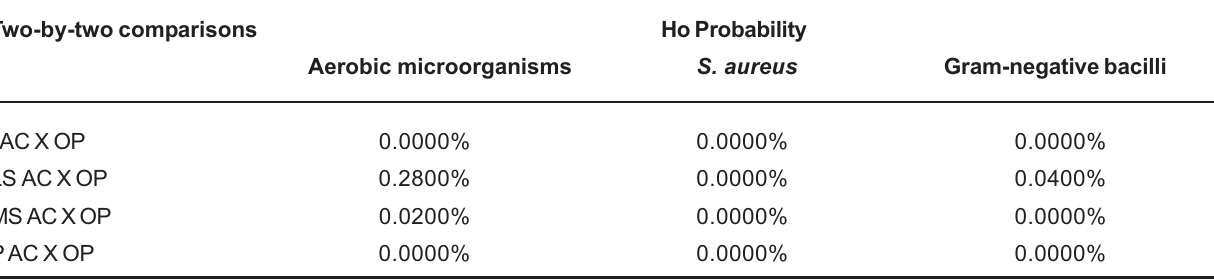
TABLE 5- Results of Spearman’s correlation test for the presence of aerobic microorganisms, S. aureus and gram-negative